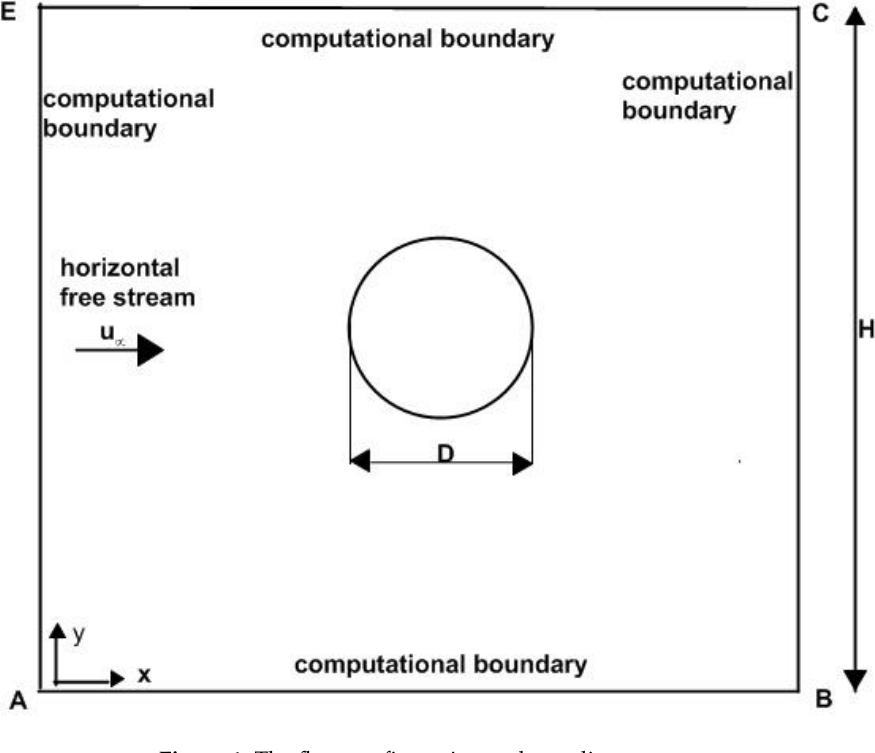
Figure 1. The flow configuration and coordinate system.